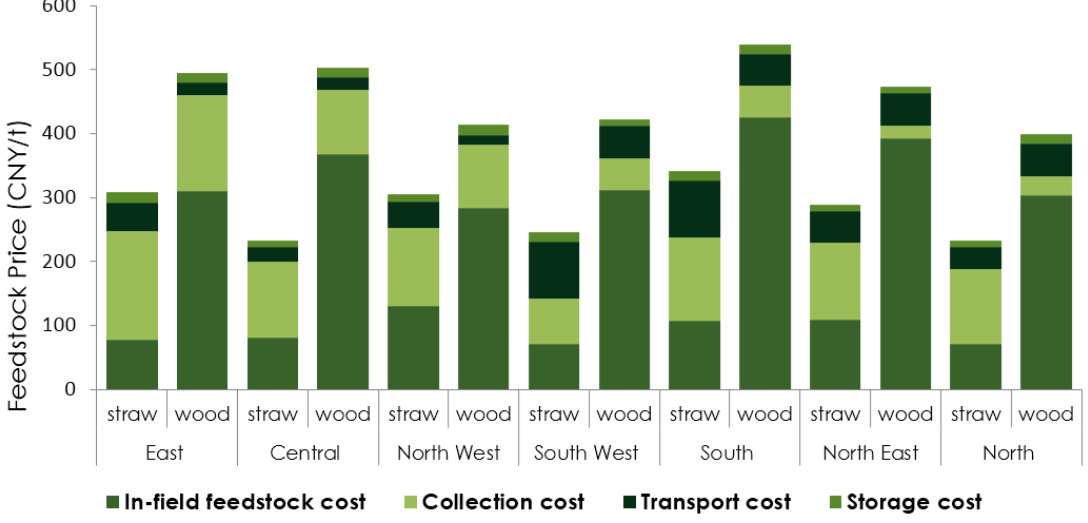
Figure 6. Regional feedstock prices (data source: field investigation).